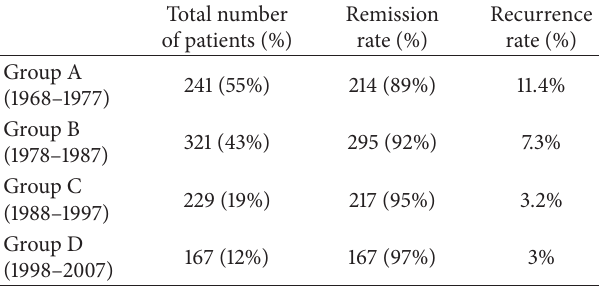
Table 2: Outcomes after thyroidectomy according to decade.